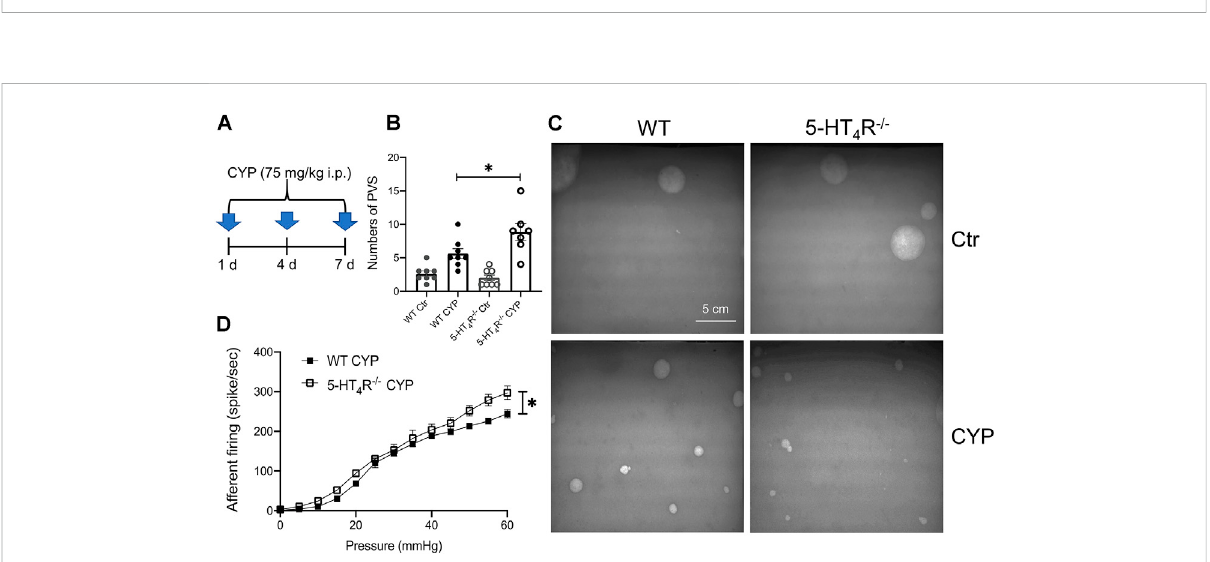
FIGURE 5 5-HT 4 R de fi ciency exacerbates bladder hypersensitivity following CYP-induced cystitis. (A) Schematic to show protocol of cyclophosphamide (CYP) treatment in WT and 5-HT 4 R − / − mice. (B) Statistics on the number of primary void spot (PVS) (Two-way ANOVA, p = 0.029, n = 7 – 8 mice for each group). (C) Photos of the typical original recordings of void spots. (D) Comparison of the pressure-bladder afferent fi ring relationship curves in the ex vivo bladder preparations from CYP-treated WT and 5-HT 4 R − / − mice (AUC analysis: WT CYP 1498 ± 28.28, 5-HT 4 R − / − CYP 1752 ± 84.89, unpaired t test, p = 0.0219, n = 5 mice for each